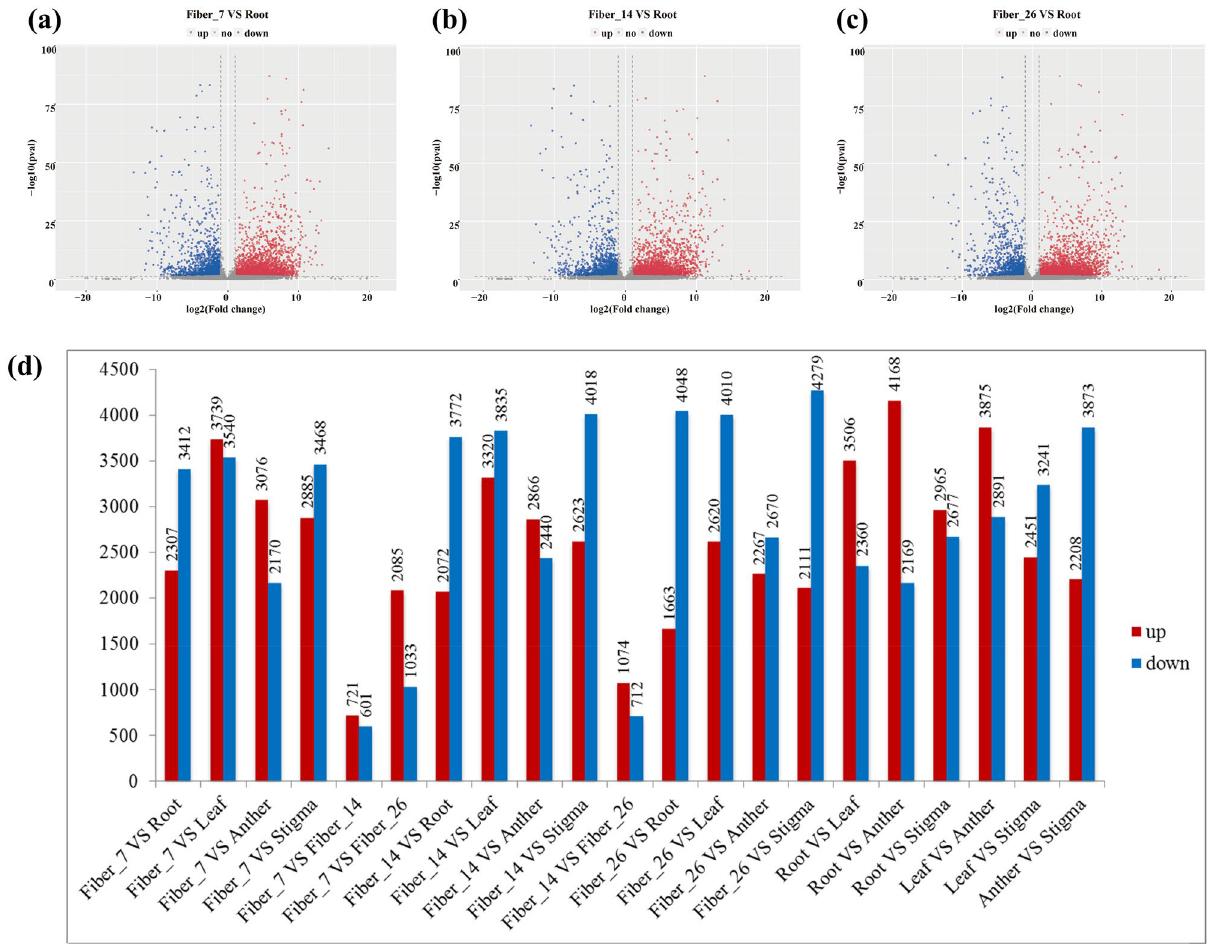
Figure 3. Upregulation and downregulation of DEGs between different tissues. ( a – c ) Volcano plot of DEGs (red dots represent upregulated DEGs, blue dots represent downregulated DEGs, gray dots represent genes that are not differentially expressed, the abscissa represents the fold change in gene expression in different samples, and the ordinate represents statistically significant differences in gene expression). ( d ) Comparison of the upregulation and downregulation of DEGs between each pair of samples in different tissues (red columns represent upregulated DEGs, blue columns represent downregulated DEGs, the abscissa represents the name of the sample comparison group, and the ordinate represents the number of